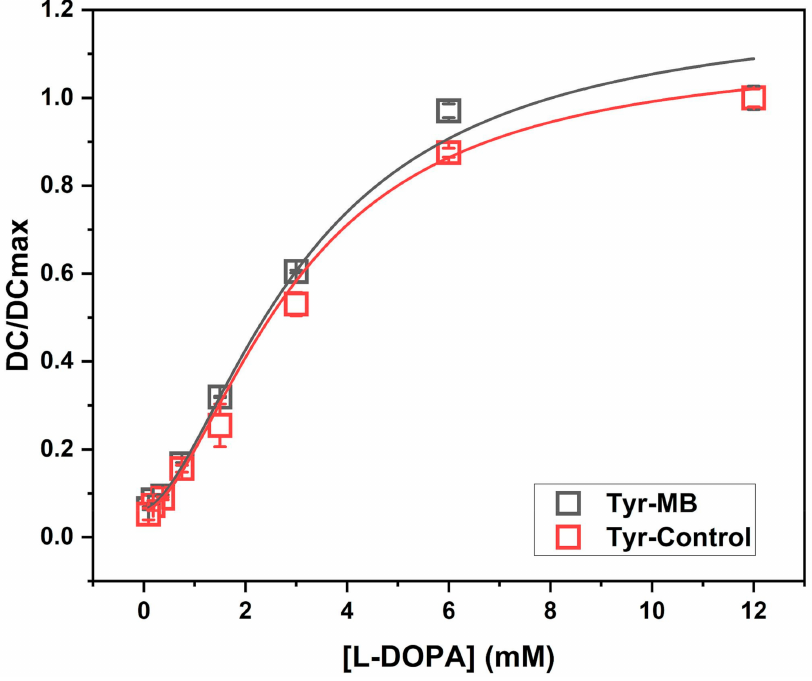
Figure 1. Dopachrome activity of Tyr-MB and Tyr control is described by the dose-response curve. The experimental points were fitted with the Hill equation with the parameters as presented in Table 1 and the caption. For comparison, dopachrome activity, DC, is normalized to the maximum response in dopachrome production, DCmax. Concentrations of L-DOPA substrate ranged with 12, 6, 3, 1.5, 0.75, 0.375, 0.1875, and 0.09375 mM. All measurements were repeated in duplicate and executed